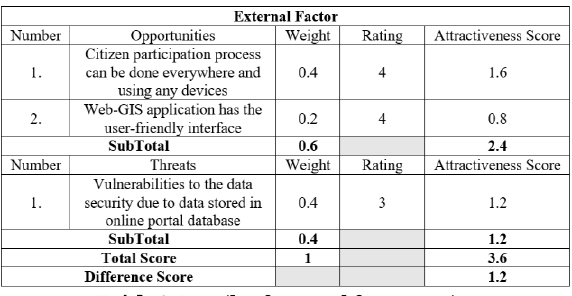
Table 6 . Details of external factor scoring